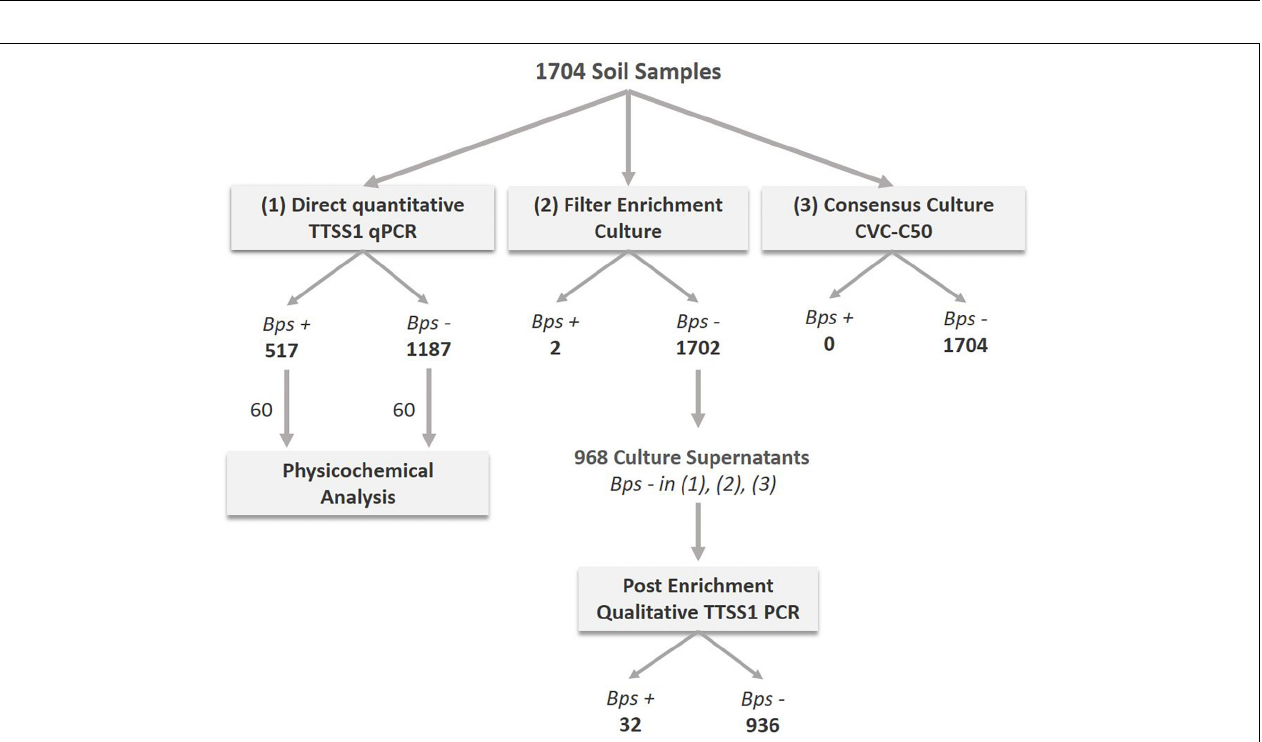
FIGURE 3 | Analyses procedure of soil samples collected close to diagnosed melioidosis cases from July 2016 to January 2019. A total of 1,704 samples were processed and analyzed by direct TTSS1-qPCR (1) and cultivated using two different culture approaches: the consensus method (3) and a drainage filter enrichment (2). The number of B. pseudomallei positive ( Bps +) and negative ( Bps– ) samples detected are given as bold numbers below the method. From July 2017 onward, 968 samples that were negative by direct qPCR and in the culture methods (2) and (3) were selected for an additional molecular analysis of the filter enrichment broth of method (2). A total of 60 TTSS1-qPCR positive and 60 negative soil samples were subjected to a physicochemical analysis.